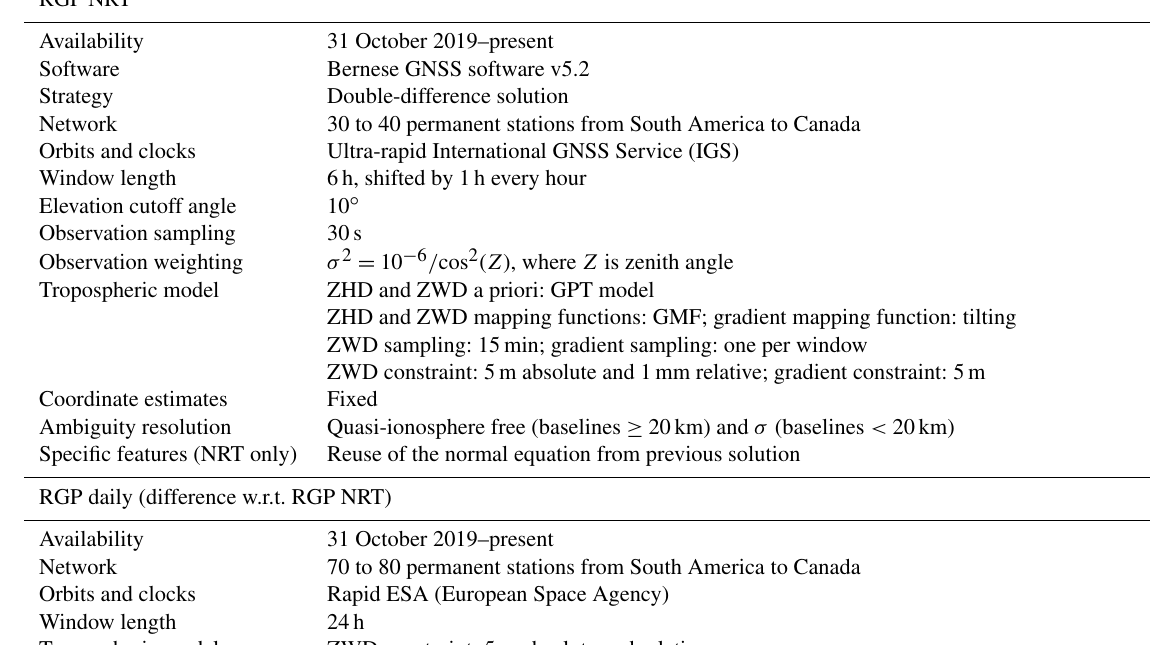
Table 1. Details of the five processing streams operated by IGN and ENSTA_B/IPGP in the framework of EUREC 4 A. RGP